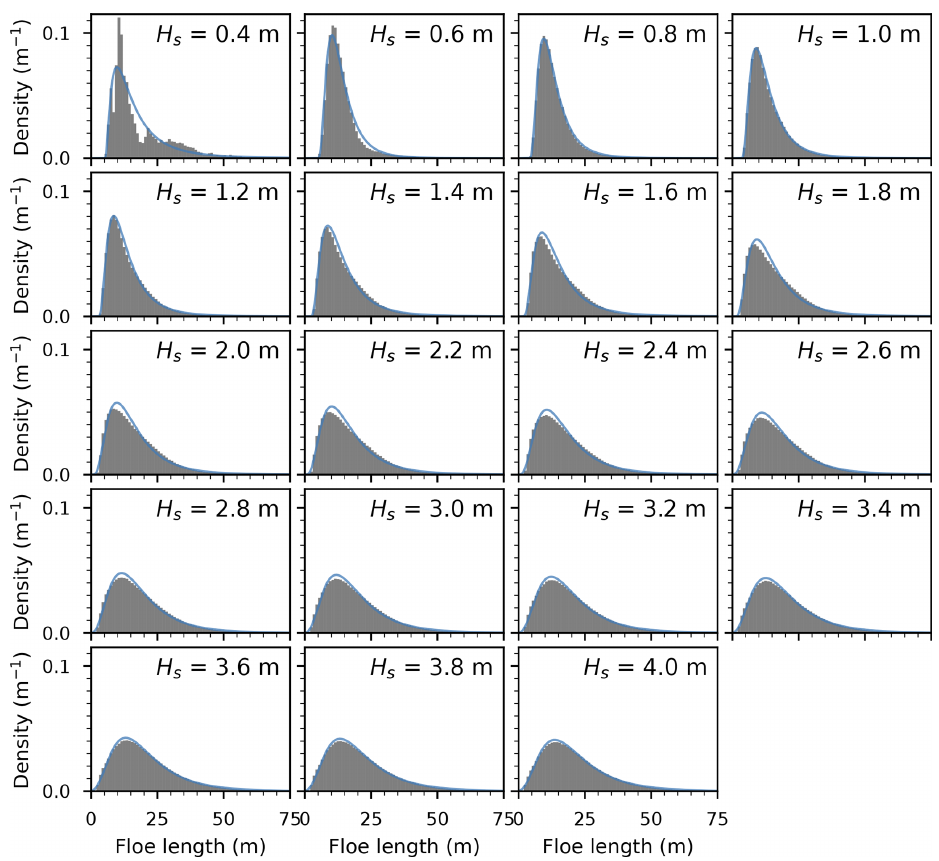
Figure C1. Histograms and average lognormal fits, as described in Sect. 5.2, for varying significant wave height.